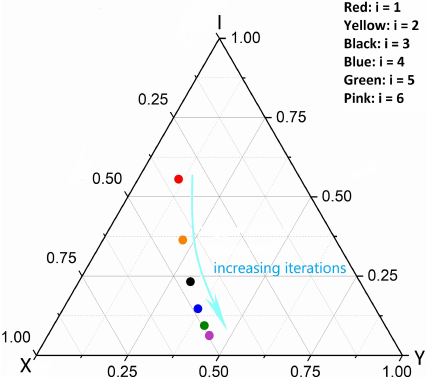
Figure 7. Ternary diagram showing connectivity of deterministic fractal-fracture patterns generated at iterations, i = 1 to 6.